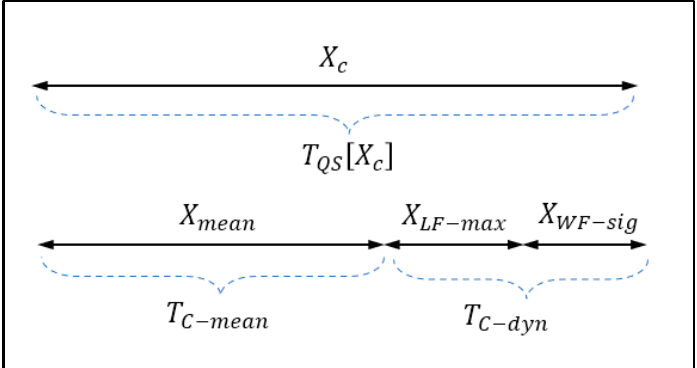
Figure 3. Relationship between horizontal distance X and the corresponding tension components in quasi-static analysis [23].